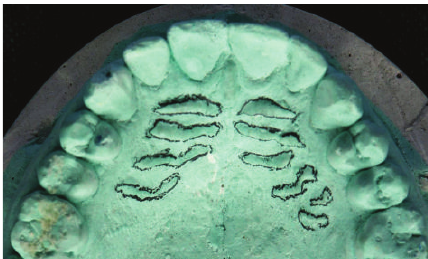
Figure 1: Photograph showing highlighted palatal rugae on maxil- lary dentulous cast.